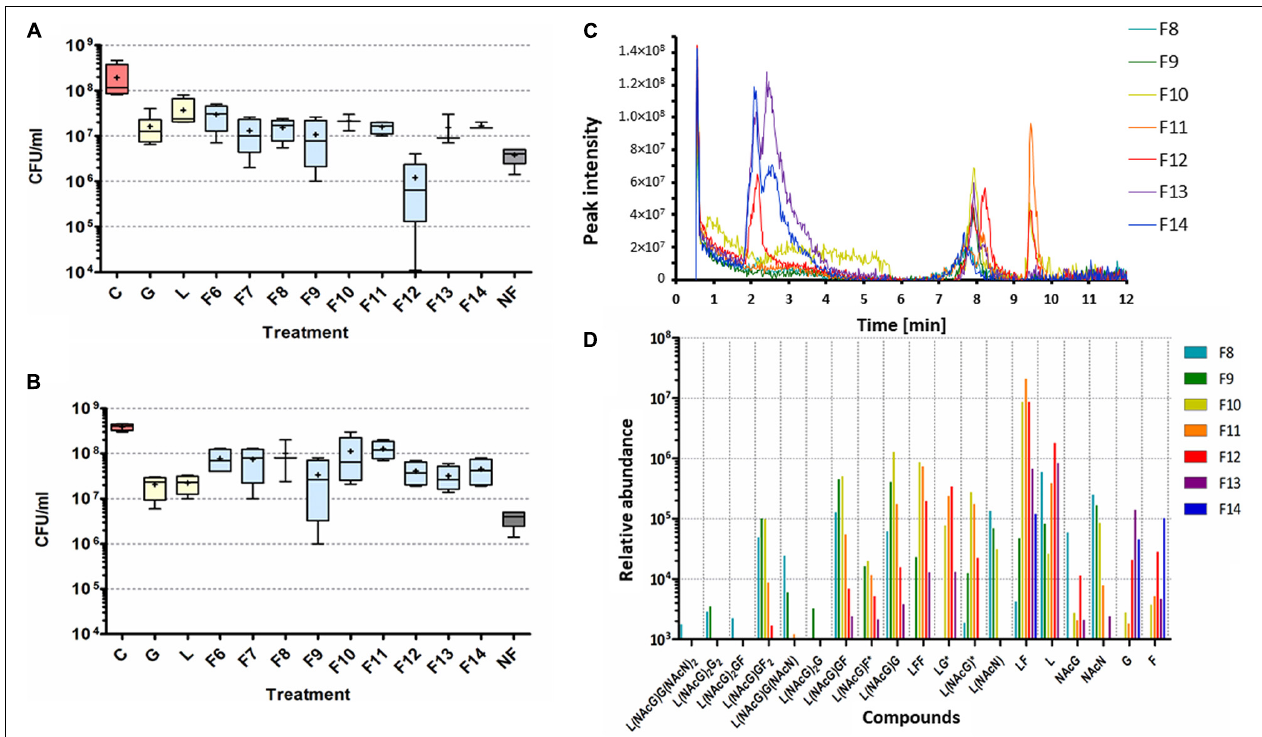
FIGURE 6 | Analysis of UHPLC/HRMS fractionated HMOs. Activities of the HMO fractions against biofilms (A) and planktonic bacteria (B) of S. aureus expressed as CFU/ml after treatment. The X-axis indicates the different treatments. C, control, no treatment (red); G, glucose; L, lactose (both yellow). The SEC fractions used for the treatment are indicated with blue bars according to their number. NF , non-fractionated HMOs (gray). = = = The boxes represent the range of the data (max to min), the bars show the standard deviation (SD), the lines in the boxes indicate the median, and the crosses indicate the averaged values. (C) UHPLC sensorgrams of the HMO fractions F8–F14. The sensorgrams were normalized to the control (phosphate-buffered saline). (D) Relative abundance of the oligosaccharides detected in the SEC fractions F8–F14 by HRMS. Only signals above a relative abundance of 103 were shown. The saccharides or saccharide moieties were calculated based on the m / z signals (mass/charge) of the H + , Na + , or K + adducts; the stereochemistry was not assessed. The compounds are given as moieties as follows: F, fucose; G, glucose or galactose; NAcG, N -acetyl glucosamine; NAcN, N -acetylneuraminic acid (sialic acid); and L, lactose; * indicates possible cleavage